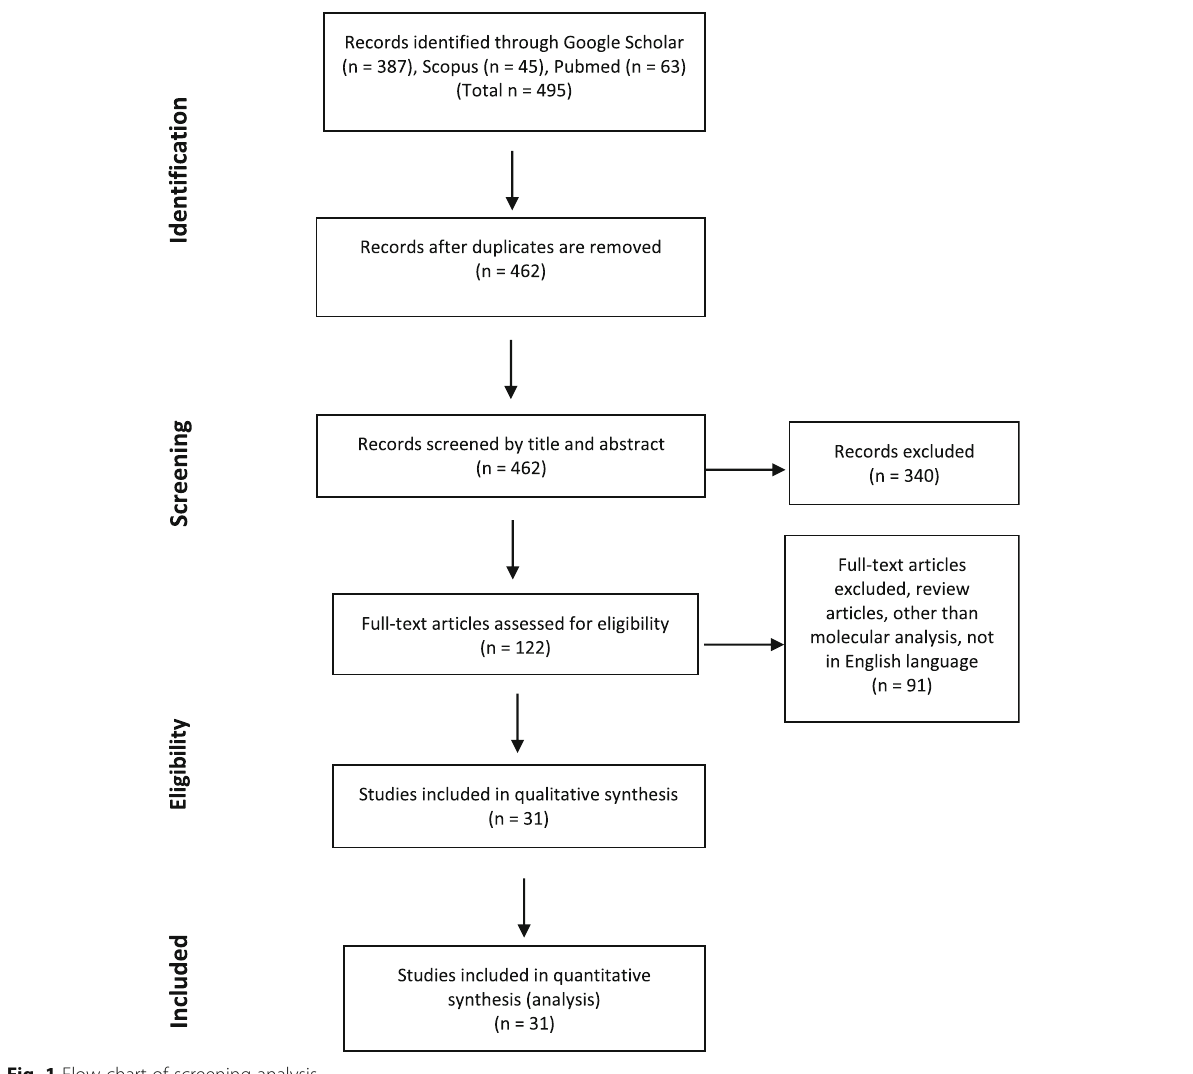
Fig. 1 Flow chart of screening analysis